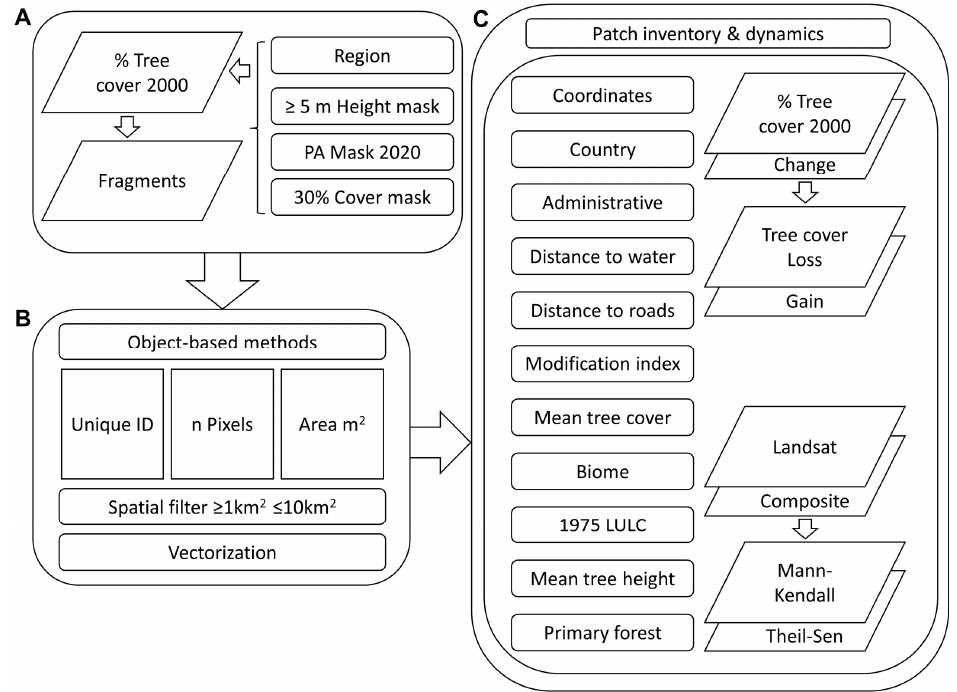
Figure 2. Workflow detailing the forest patch detection approach. ( A ) A threshold of 30% tree cover, tree height mask of ≥ 5 m, a protected area mask and a country filter. The resulting forest fragments are processed using object-based methods ( B ), inventory attributes are appended to the resulting forest patches ( C ).